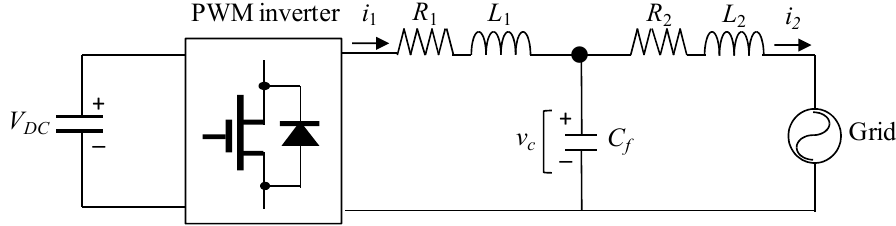
Figure 1. Configuration of the simplified equivalent circuit of three-phase grid-connected inverter with LCL filter. PWM: pulse width modulation